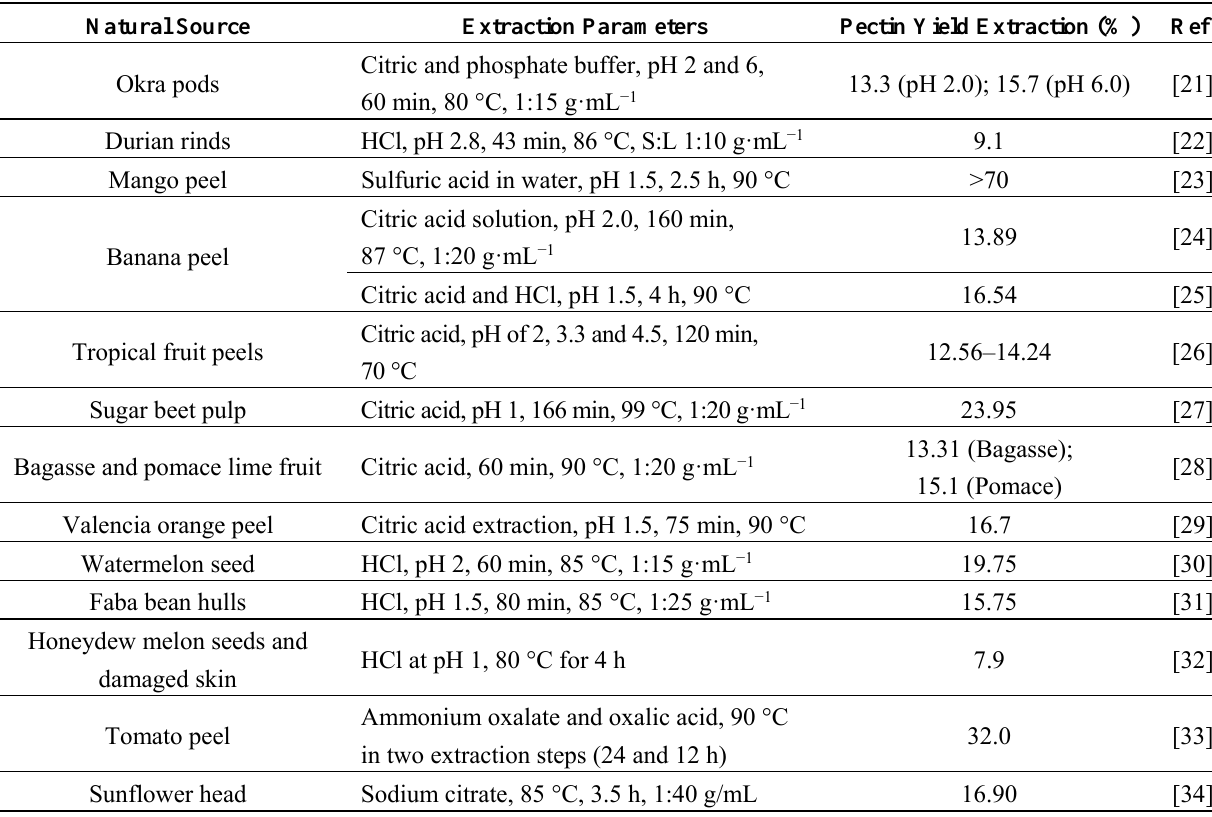
Table 1. Natural pectins extracted by solvent extraction